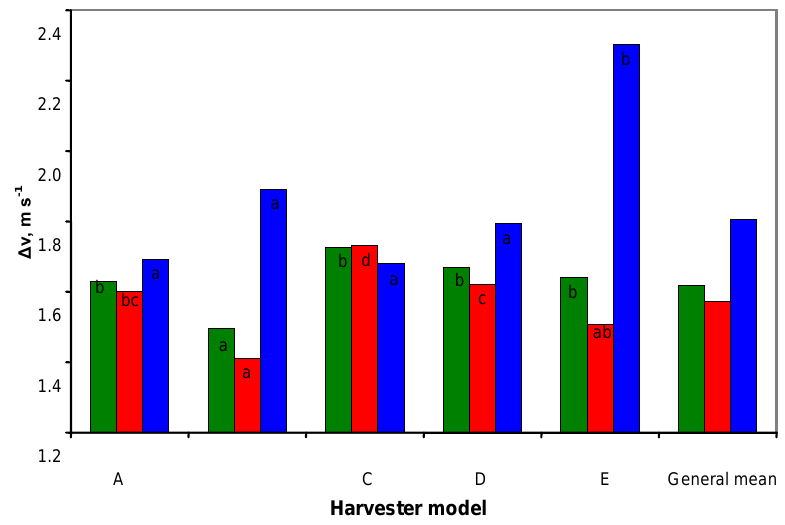
Figure 7. Velocity change (  v, in m s − 1 ) for each harvester and each zone:  harvester mean value;  zone 1;  zone 2. Zone 1: combine elements from cutting device to second belt. Zone 2: combine elements from second belt to loading onto the trailer. Different letters in each column are significantly different (p <